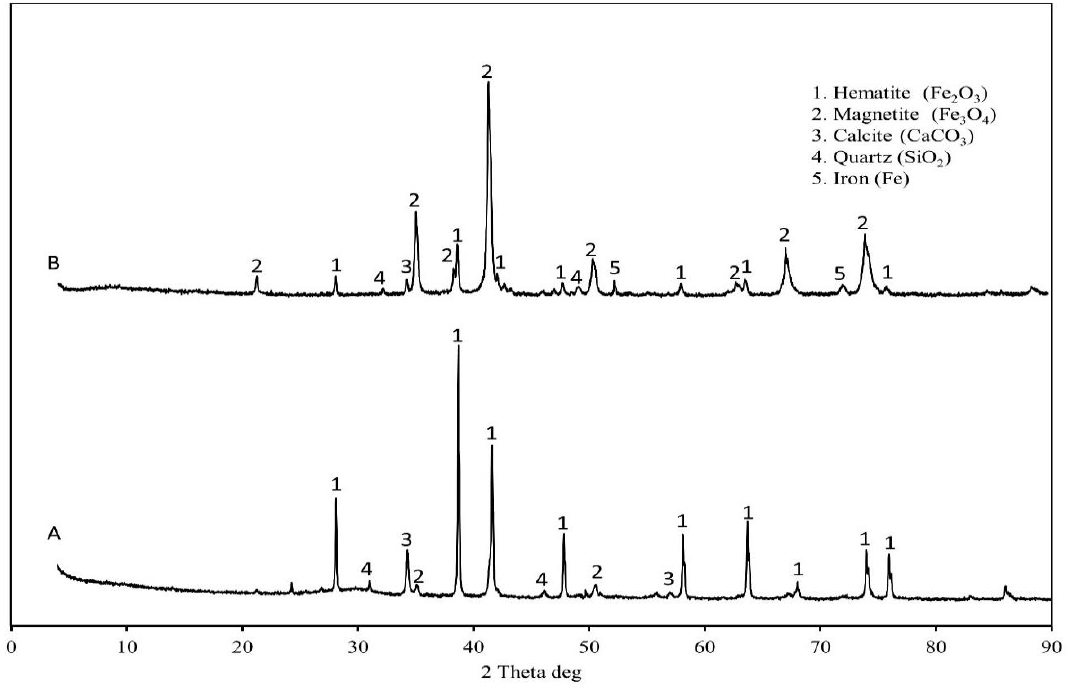
Figure 1. XRD (X-ray diffraction) patterns: ( A ) BF (blast furnace) sludge; ( B ) BOF (basic oxygen furnace) sludge.